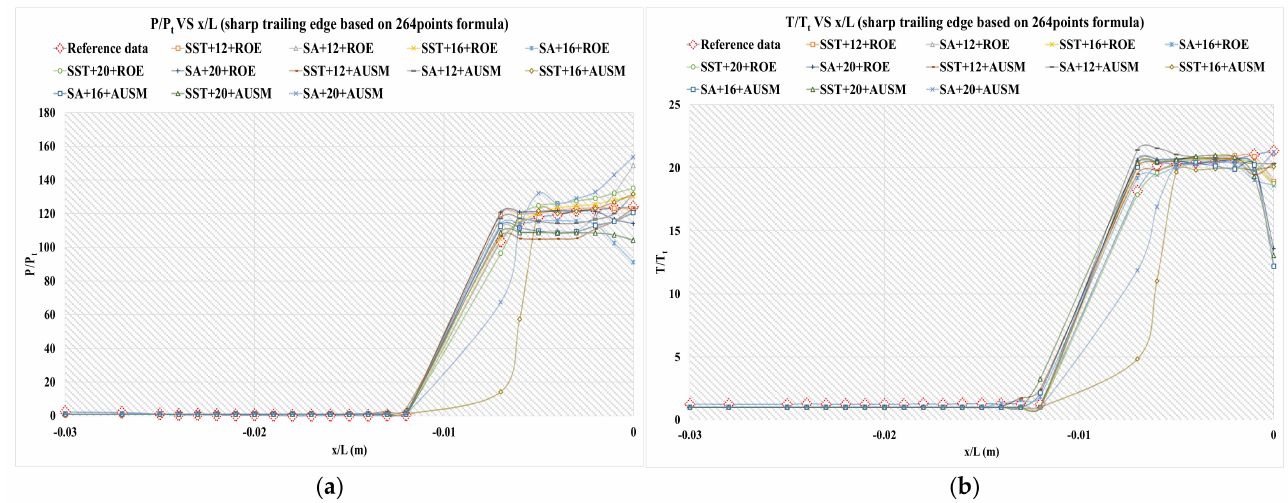
Figure 14. ( a ) Distributions of P/P t of sharp trailing edge based on 264 points formula; ( b ) Distribu- tions of T/T t of sharp trailing edge based on 264 points